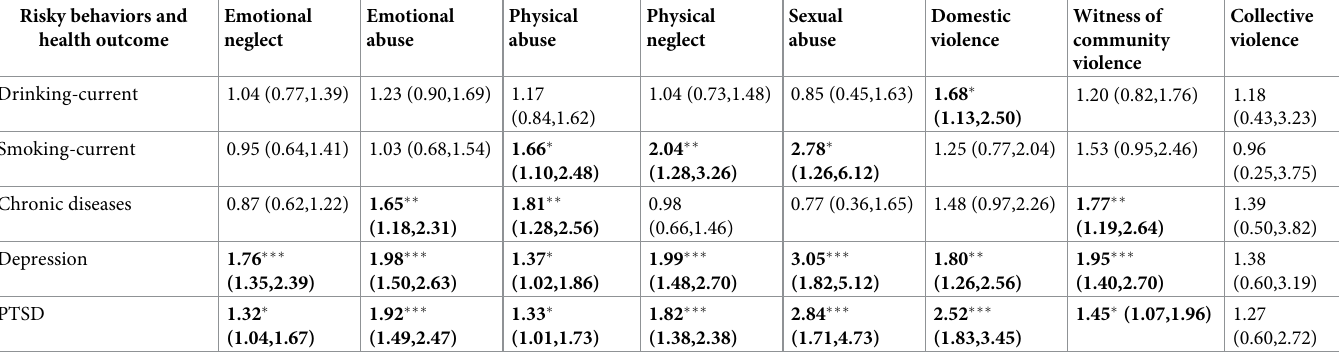
Table 4. Multivariate logistic regression models for relationship between ACE categories and risky behaviors and health outcomes.